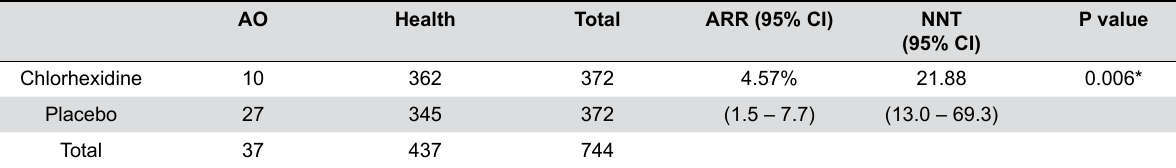
Table 3- Incidence of alveolar osteitis in patients treated with chlorhexidine 0.12% mouthwash or